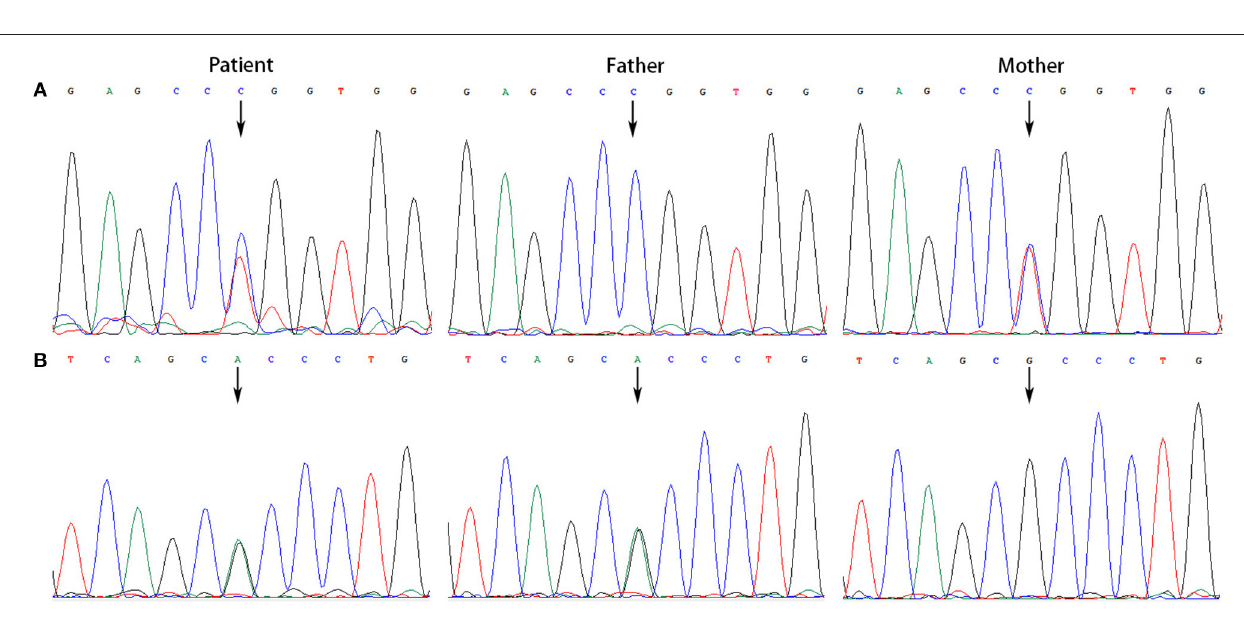
FIGURE 3 | Sanger sequencing of the genomic DNA from patient 2 and his parents. (A) Patient 2 with a heterozygous variant of c.473C > T, his father with a normal genotype, and mother with a heterozygous variant of c.473C > T. (B) Patient 2 with a heterozygous variant of c.1456G > A, his father with a heterozygous variant of c.1456G > A, and mother with a normal